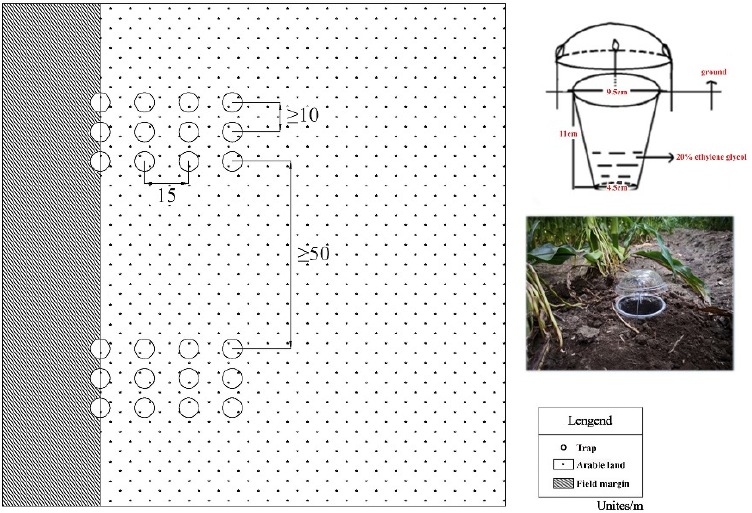
Figure 3. A map of sample points for epigeic arthropods in the sampling areas and a map of pitfall trap.